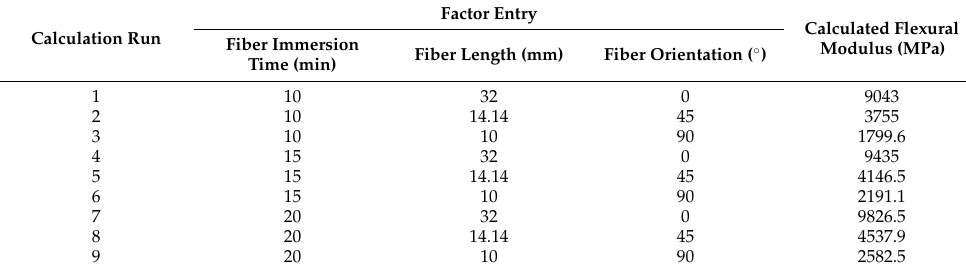
Table 8. Proposed fiber length for maximizing flexural modulus.